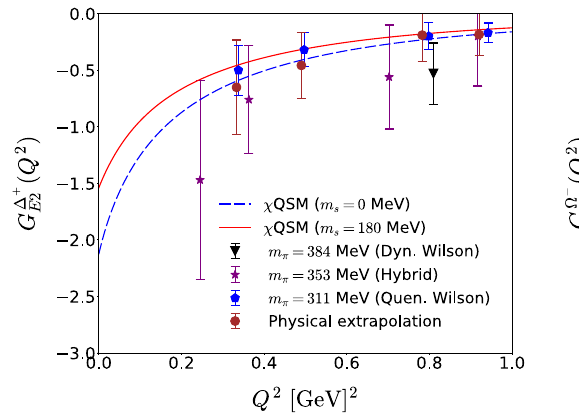
whereas the solid ones present the E2 form factors with the effects. The lattice data are taken from Refs. [21,23,24]. Notations are the same as in Fig. 7